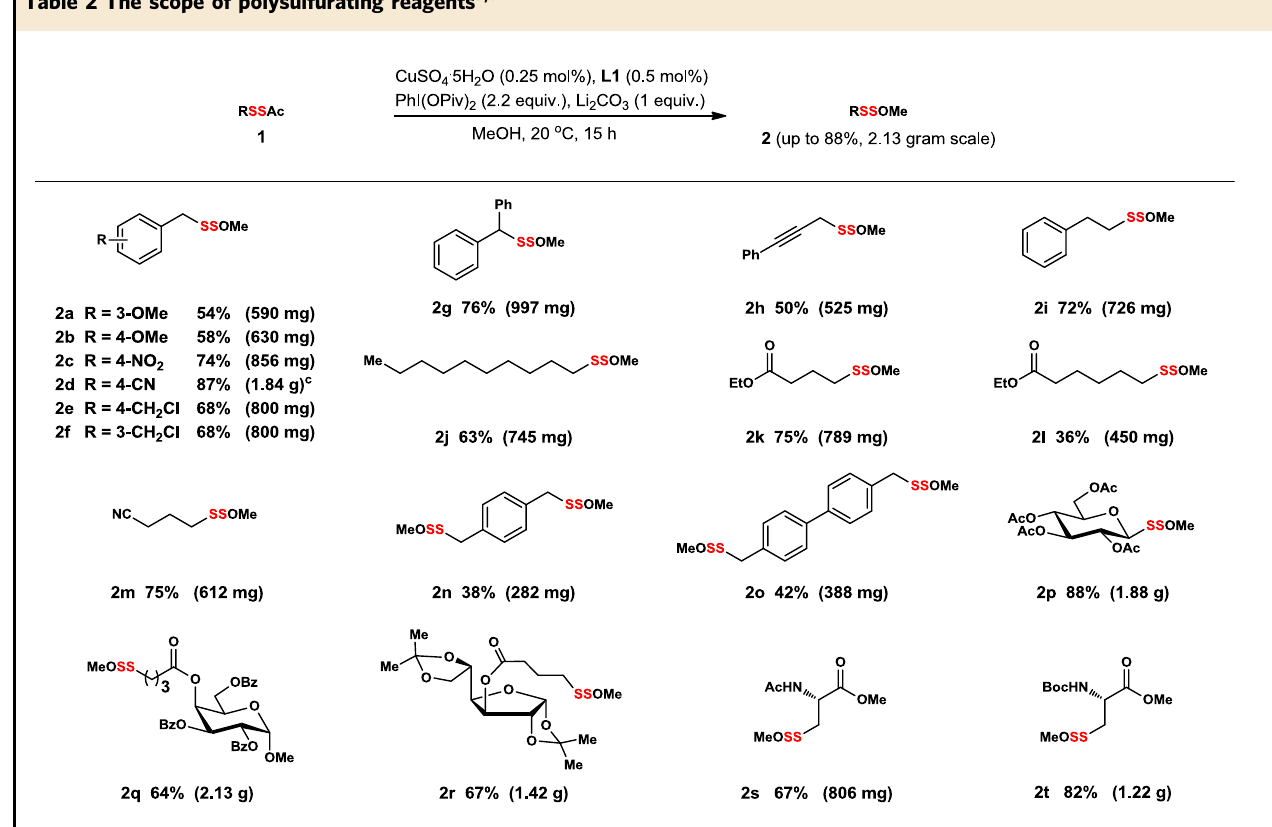
Table 2 The scope of polysulfurating reagents